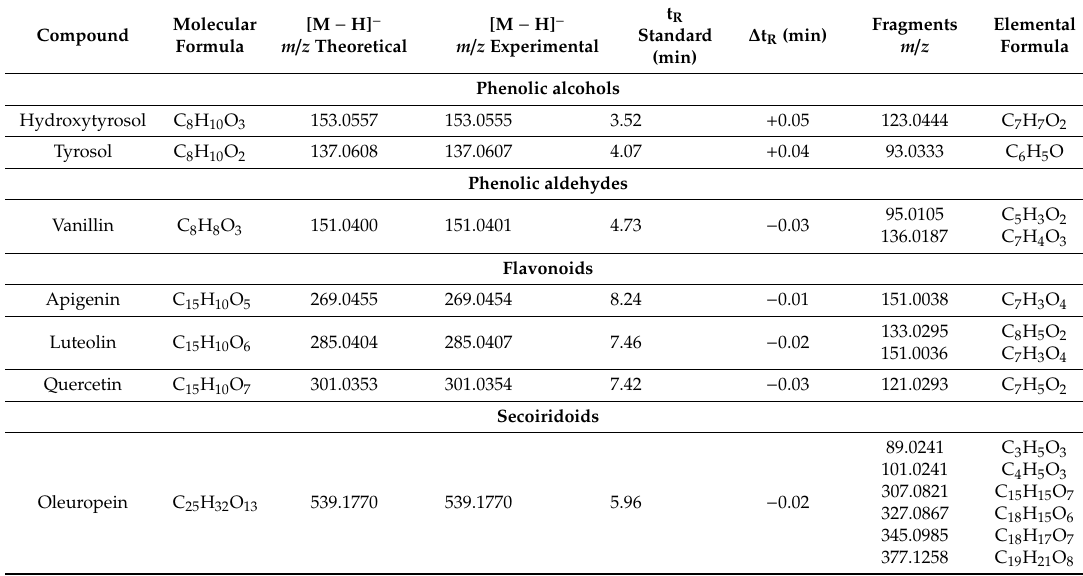
Table 6. Target screening results in